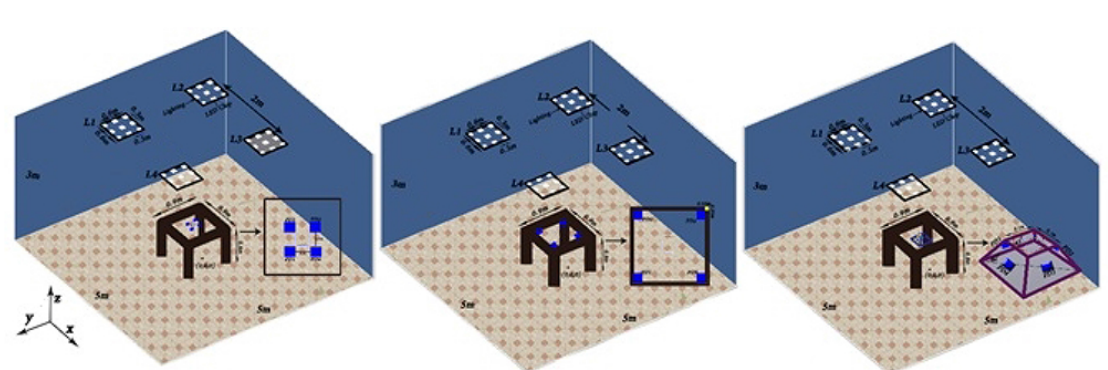
Figure 2. Configuration A (PD in the center of the table), B (PD at the corners of the table) and C (PD are aligned to their correspondent